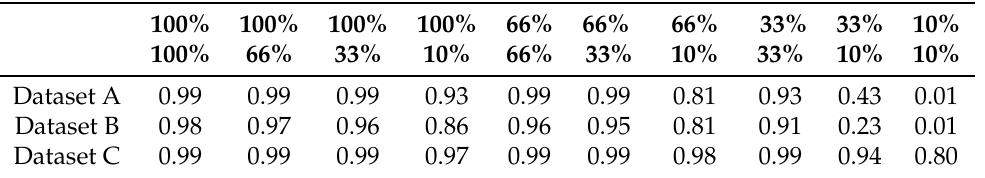
Table 9. Acc with various breakdowns of samples.